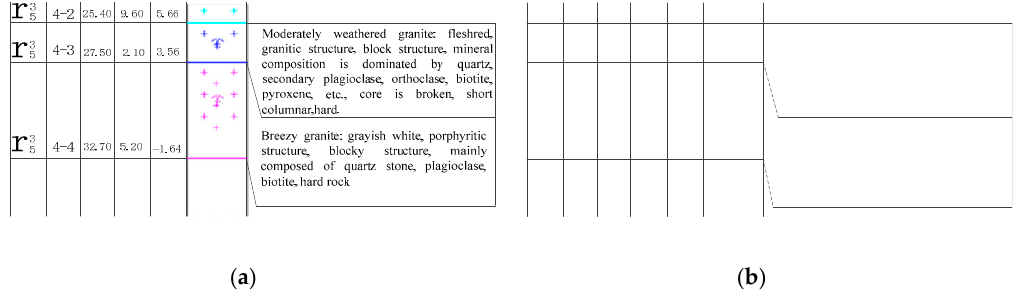
Figure 5. The borehole log table line obtained via the Hough transformation. ( a ) Borehole log; ( b ) table line.